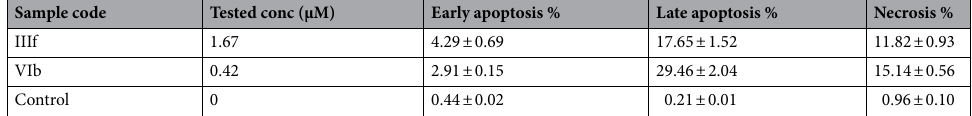
Table 6. Apoptosis population percentage of ( IIIf ) and ( VIb ) treated MCF-7 cells after 24 h incubation.